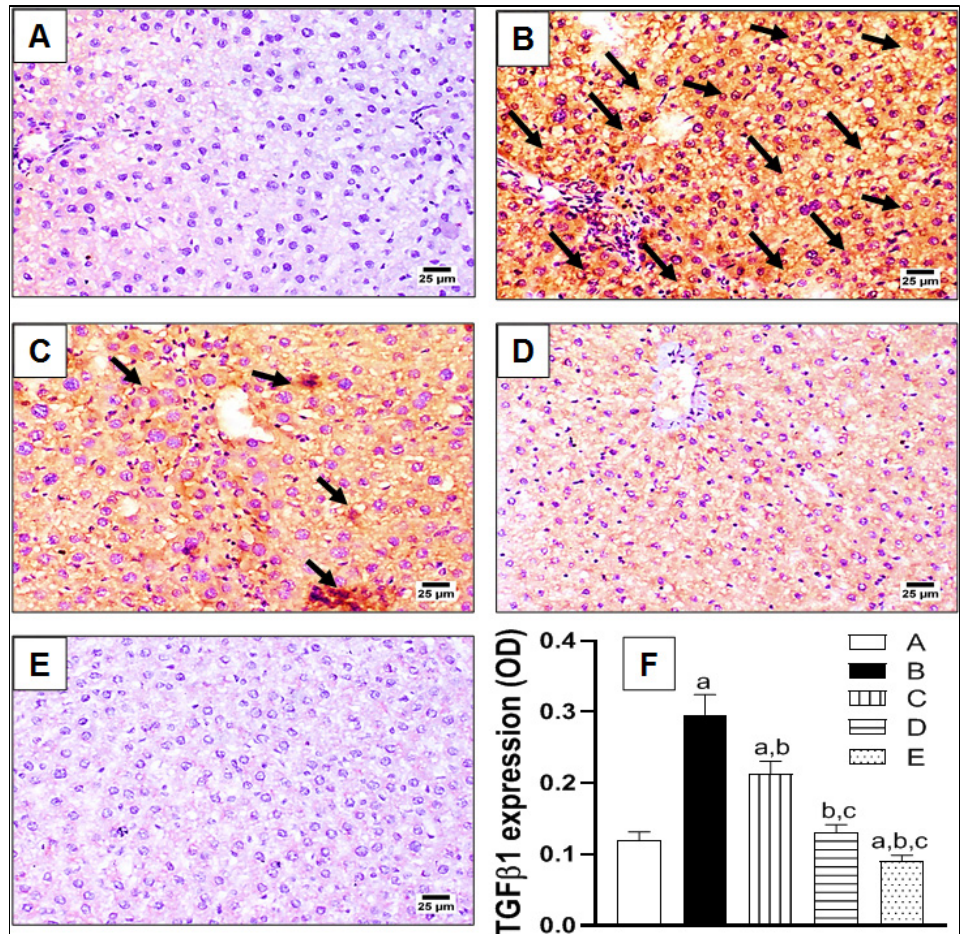
Figure 4. The effect of lycorine on the expression of transforming growth factor β 1 (TGF β 1) by immunohistochemical staining in a rat model of TAA-induced liver fibrosis. ( A ) Control group; ( B ) TAA-challenged group; ( C , D ) lycorine-treated groups at doses of 0.5 and 1.0 mg/kg, respectively; ( E ) lycorine-alone group; ( F ): quantitative image analysis for TGF β immunohistochemical staining, as optical density (OD) across six different fields. Data are presented as mean ± S.D. ( n = 6). (a), (b), (c) Statistically significant from the control, TAA, and TAA + lycorine 0.5 mg/kg/d groups, respectively, at p < 0.05 using one-way analysis of variance (ANOVA) followed by Tukey’s as a post- hoc test.